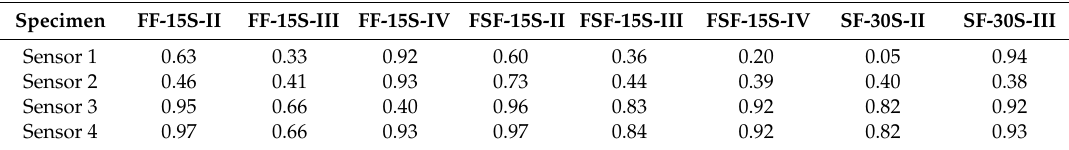
Table 6. Correlation coe ffi cient between signals obtained by a post-embedded piezoceramic sensor and applied deformation under dynamic